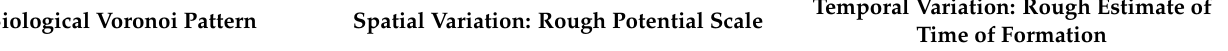
Temporal Variation: Rough Estimate of Time of